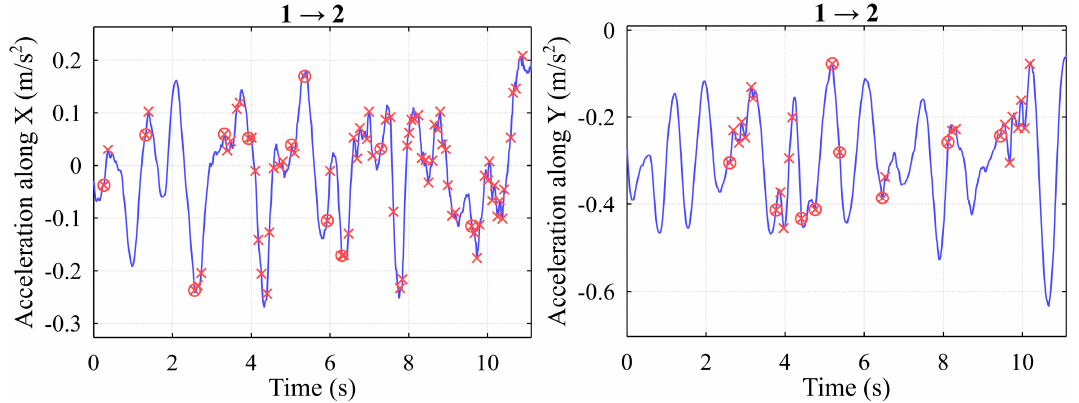
Figure 10. Use case No.2 with the standard IDM parameters (detected impacts: ( left ) 11; ( right ) 9).